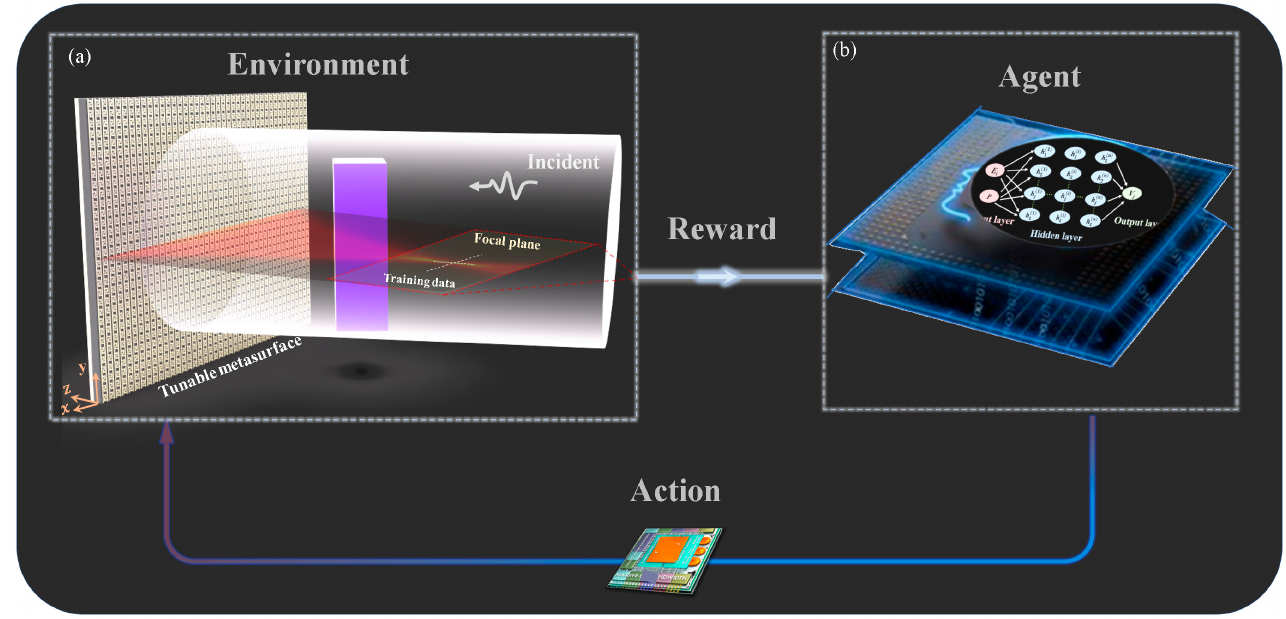
Figure 1. Proposed SAC-M Architecture. ( a ) Incident wave, metasurface, and object constitute complex environments simultaneously. ( b ) Agent continuously collects and analyzes data in real time.